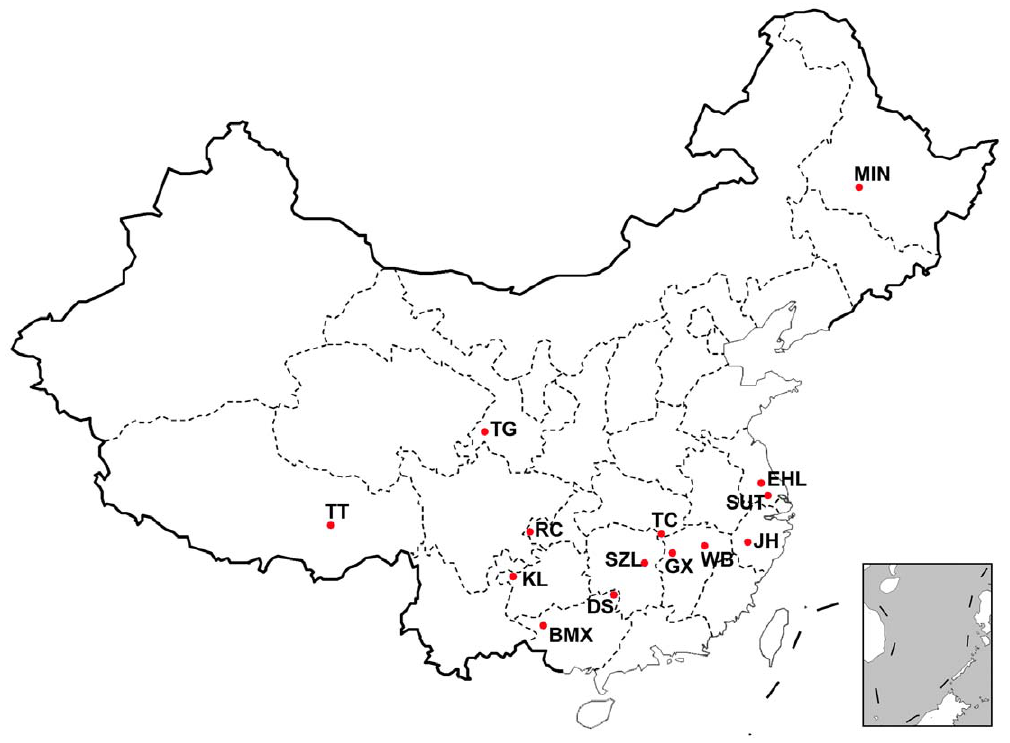
Figure 1. The geographic locations of Chinese pigs in the present study. BMX, Bamaxiang; DS, Dongshan; EHL, Erhualian; GX, Ganxi; JH, Jinhua; KL, Kele; MIN, Min; RC, Rongchang; SUT, Sutai; SZL, Shaziling; TC, Tongcheng; TG, Tibetan (Gansu); TT, Tibetan (Tibet); WB, Chinese wild boars.